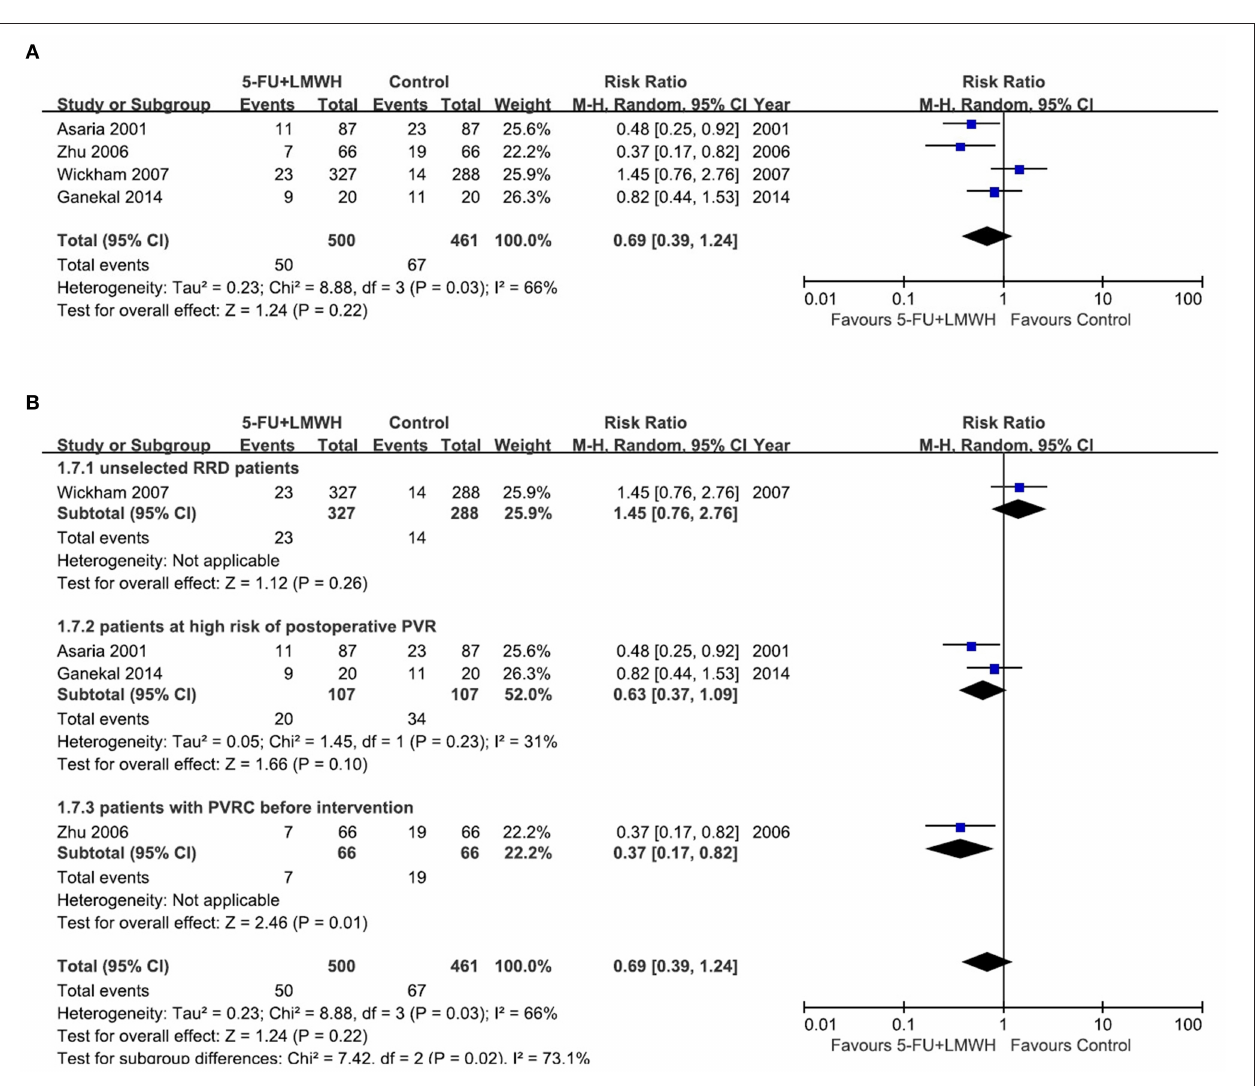
Frontiers in Medicine |